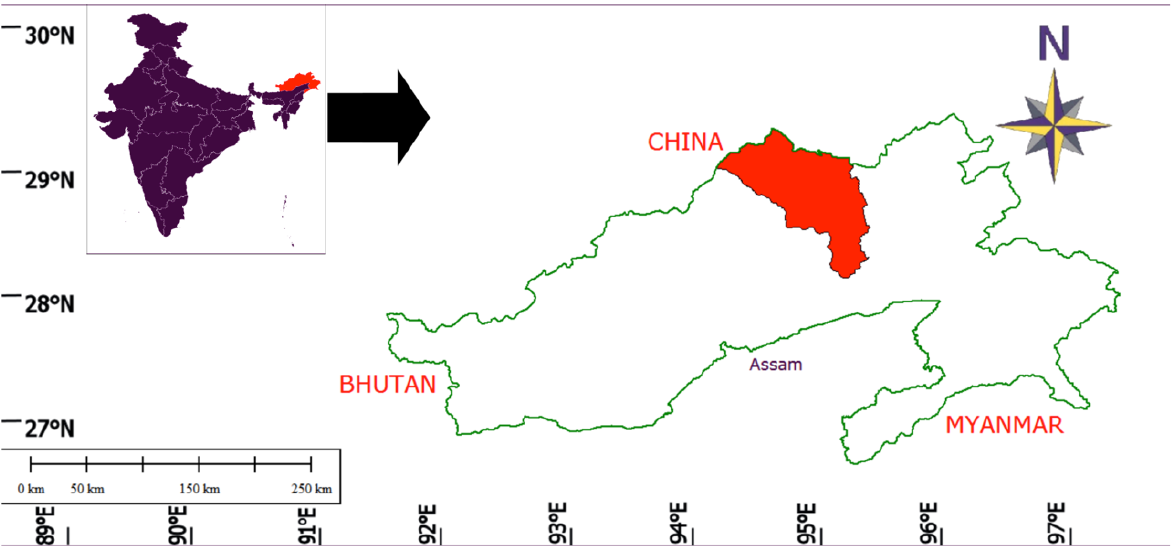
Figure 1 . Map showing the location of Upper Siang District (in red) within the northeast Indian state of Arunachal Pradesh. Inset map shows the location of the state of Arunachal Pradesh within